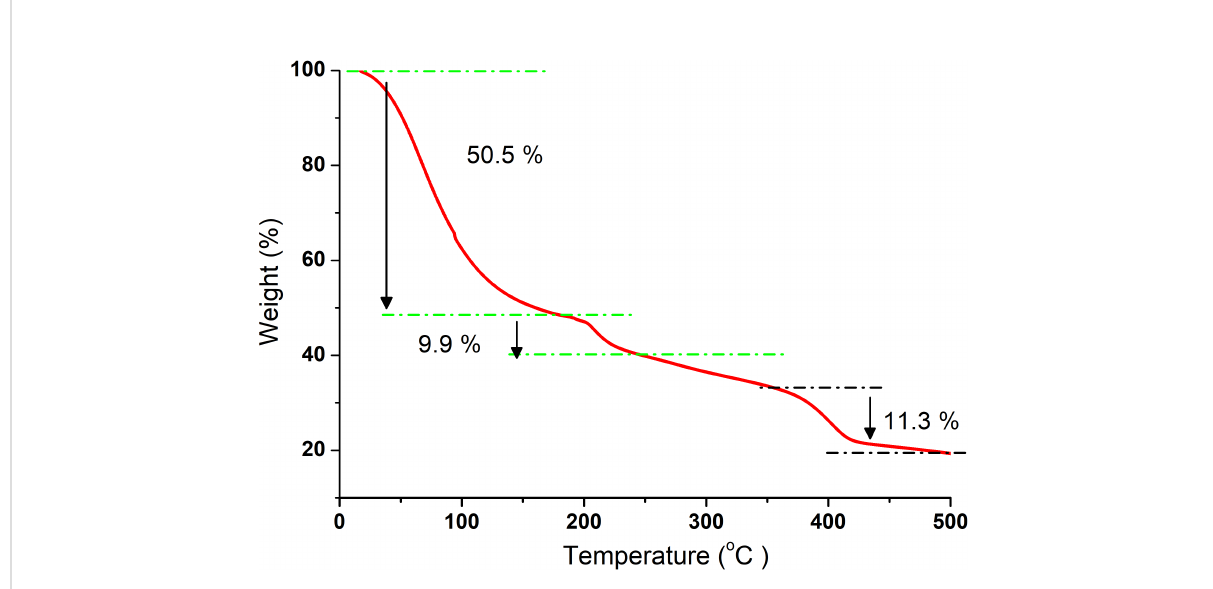
FIGURE 5 Percentage of weight loss vs. temperature at a rate of 10°C/min.